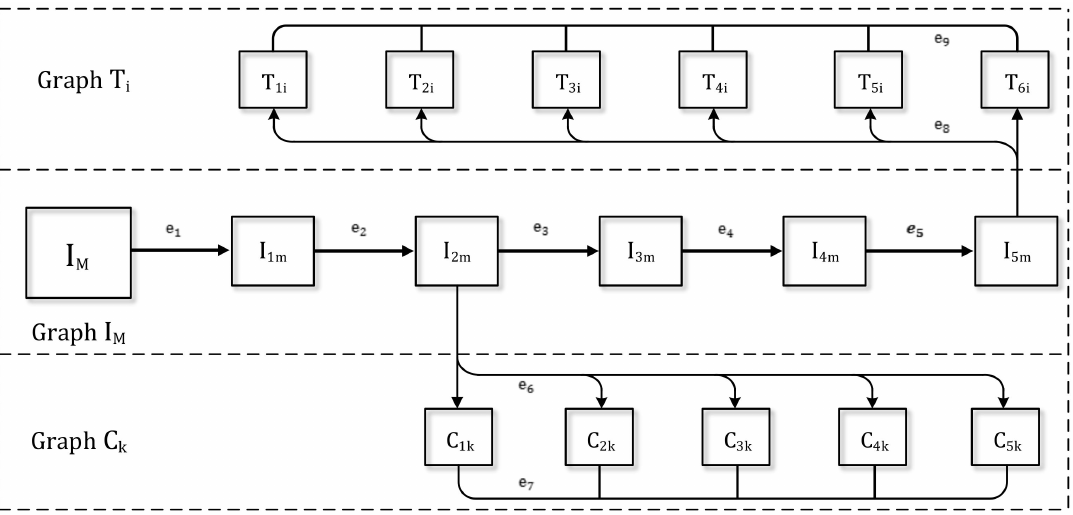
Figure 6. Formal model of the TDTN protection